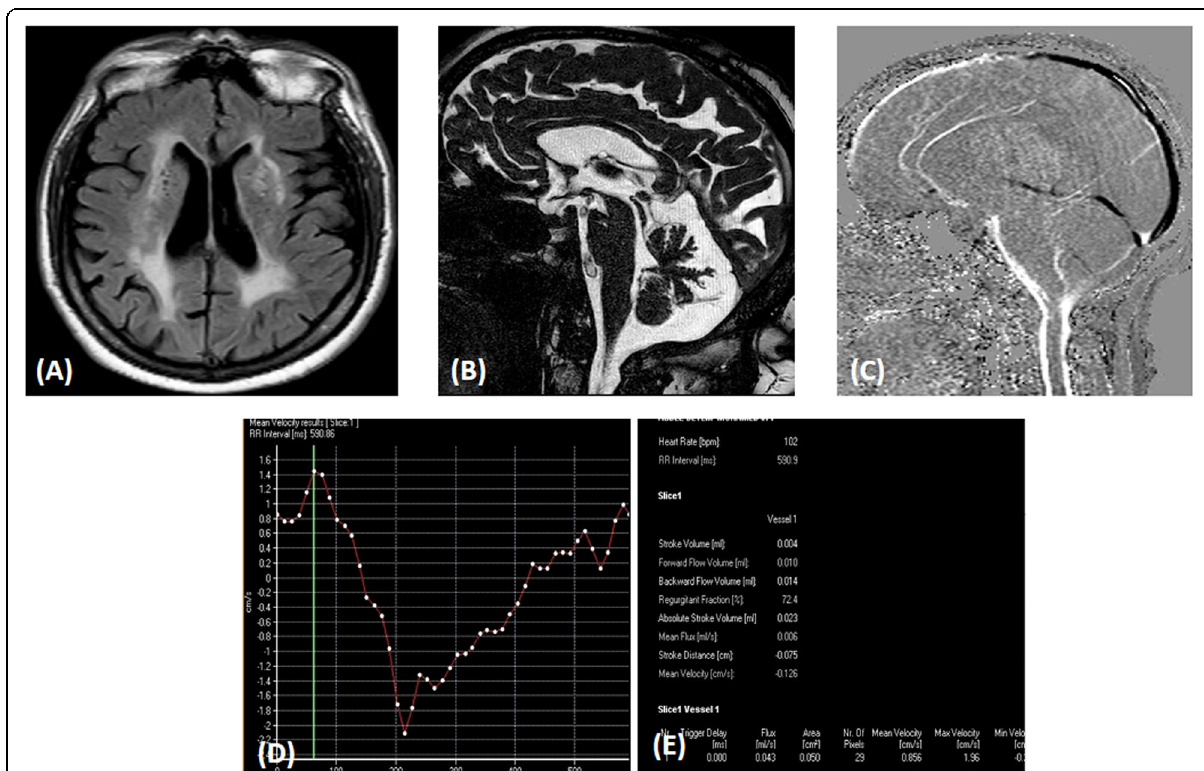
Fig. 6 Female patient presented with gait disturbance and difficult urinary control. a MRI axial FLAIR, mild dilatation of the lateral ventricles, and white matter abnormal hyperintensity representing ischemic changes. b 3D DRIVE image showing patent normal aqueduct. c Sagittal phase image in systole showing CSF flow in the aqueduct of Sylvius as shades of white. d Velocity time curve showing CSF in both diastole and systolic PDV = 1.4 cm/s, PSV = 2.2 cm/s, and Vmax = (1.4 + 2.2)/2 = 1.8 cm/s. e CSF flow curve associated table, Forward flow volume = 10 μ l,